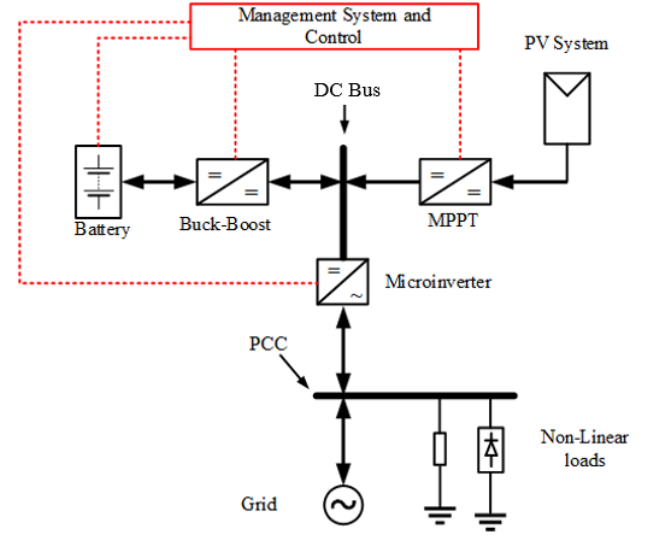
Figure 1. Topology of